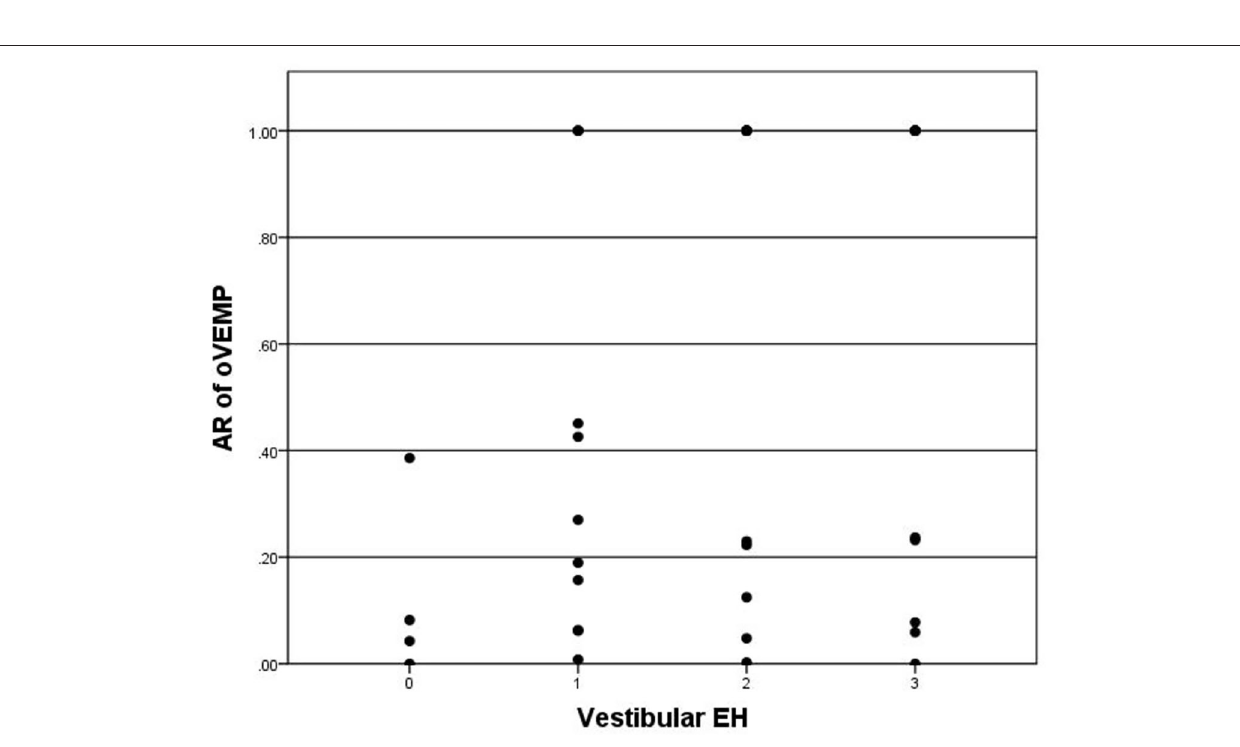
Frontiers in Surgery |